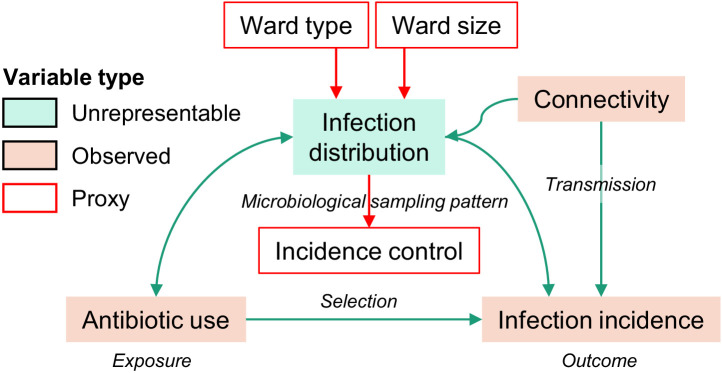
Directed acyclic graph representation of causal assumptions.Boxes denote variables and arrows denote assumed causal relationships, from cause to effect. In the assumed model, the infection distribution variable opens a biasing path between antibiotic use (the exposure) and the incidence of infections with the pathogen variant of interest (the outcome). The infection distribution is an unrepresentable variable which cannot be directly adjusted for, but which might be represented by proxy variables (see Materials and methods). To define these proxy variables, we assume that ward type, size, and the incidence control value capture much of the variability of the unrepresentable infection distribution. Under this assumption, these measured variables are used as a proxy adjustment set to control for confounding by the infection distribution. Of note, the infection distribution influences the volume of antibiotic prescriptions, and antibiotic use also influences infections by altering the population structure of pathogens. Thus, the causal link between the infection distribution and antibiotic use is (possibly) bidirectional. However, the bidirectional link between antibiotic use and infection distribution does not prevent the identification of the causal effect under the assumption that the proxy adjustment set is valid.